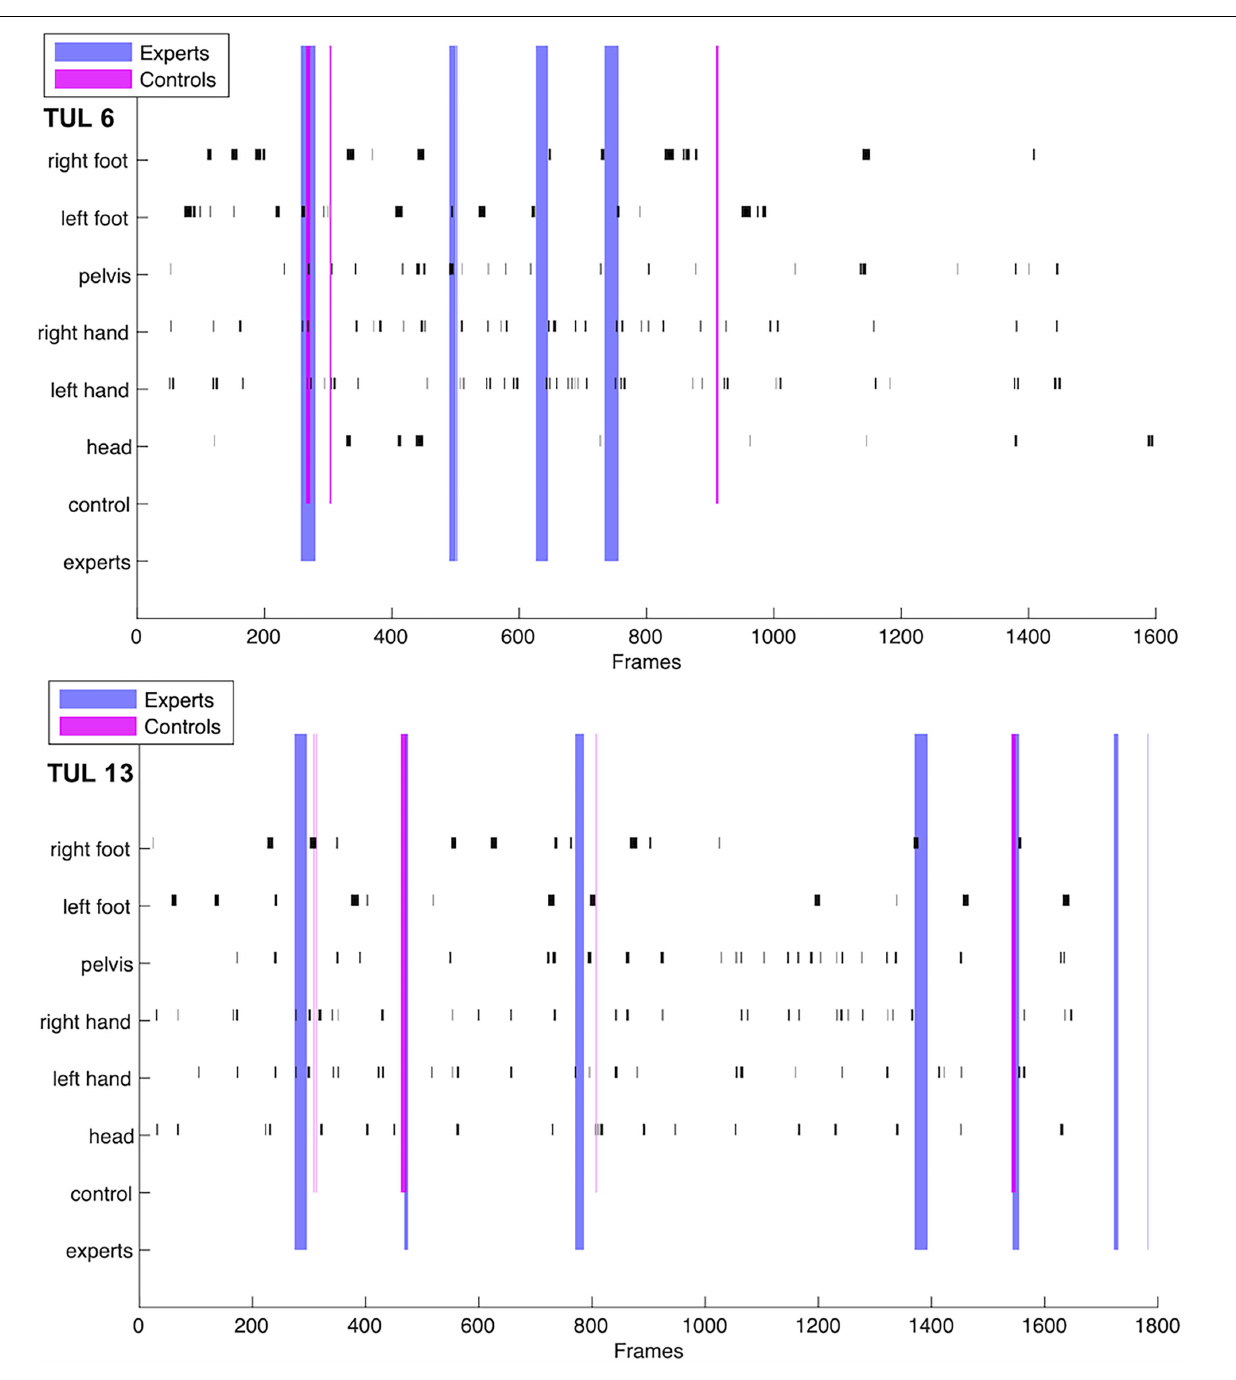
FIGURE 6 | Acceleration maxima (black bars) as obtained for the whole video duration of two ITF sequences (Tul #6 and #13) are shown for six different body parts. Colored lines represent agreed boundaries in the same videos for the two groups (blue – experts; pink – novices, i.e., “controls”). Line width corresponds to length of period in which values were above the mean (i.e., agreed boundaries,